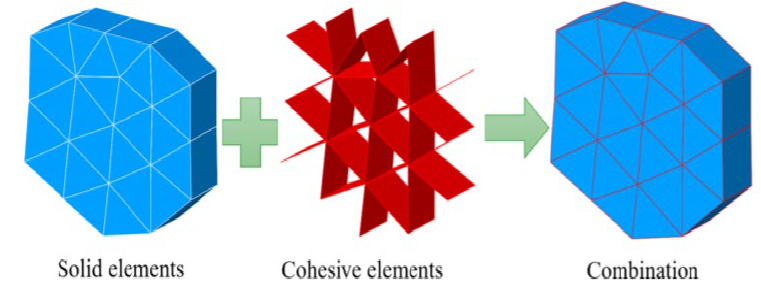
Figure 51. The principles of FDEM [255].